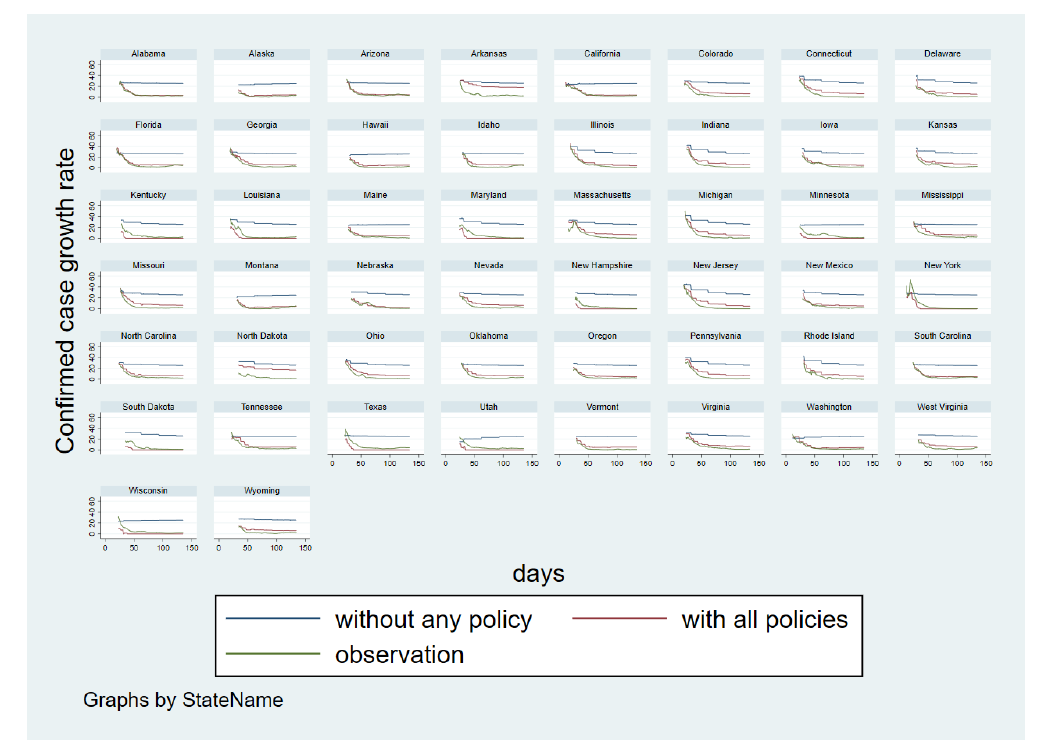
Figure A4. Counterfactual analysis: state-specific time trends for the confirmed case growth rate with and without social distancing measures based on smoothed data (7-day moving average).